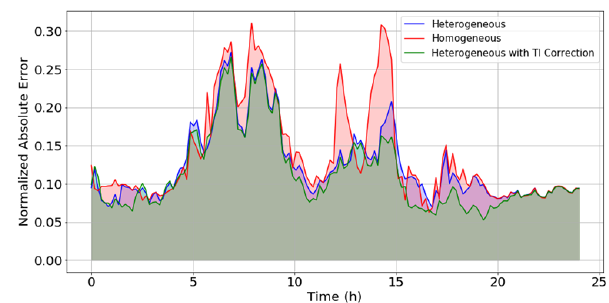
Figure 18. Sum of the normalized absolute error at each turbine in the wind farm, computed at each time